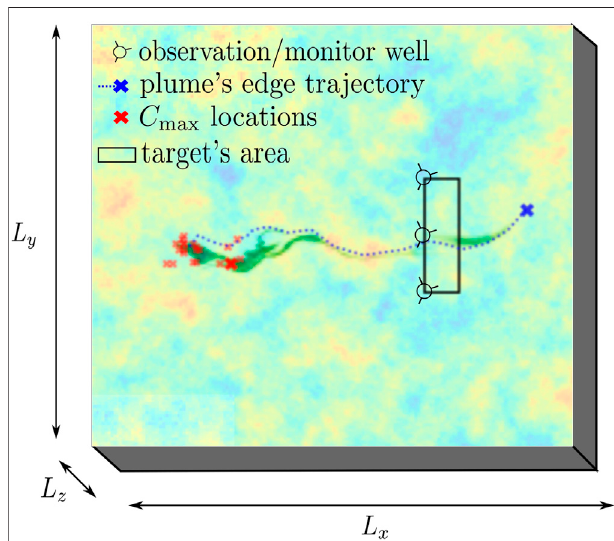
FIGURE 4 | Schematic representation of the contaminant plume, in green, for a given random realization of the hydraulic conductivity fi eld. The fi gure shows where observations wells (circles) are positioned over the target area (rectangle) and how the locations of the leading edge of the plume (blue cross) and of the maximum contaminant concentration (red cross), experienced ateach time stepsofthesimulation, evolveintime.Thetrajectory oftheleadingedgeoftheplume followsthetrajectorygivenbythedottedblue line. The location of the maximum concentration of the plume bounces from one location to another (see red